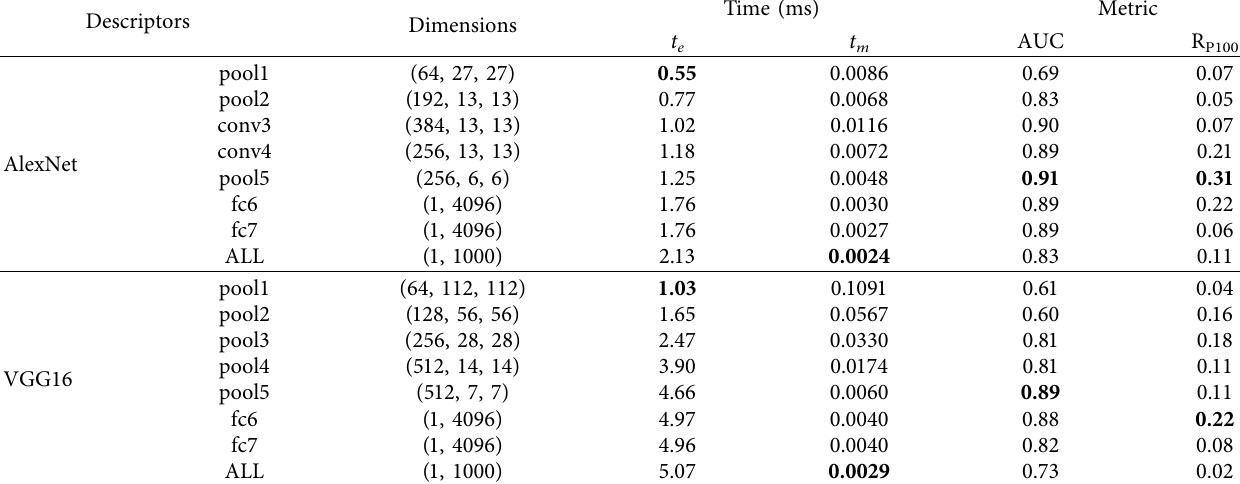
Table 8: Comparison of diferent feature levels of CNN-based descriptors (with a GPU